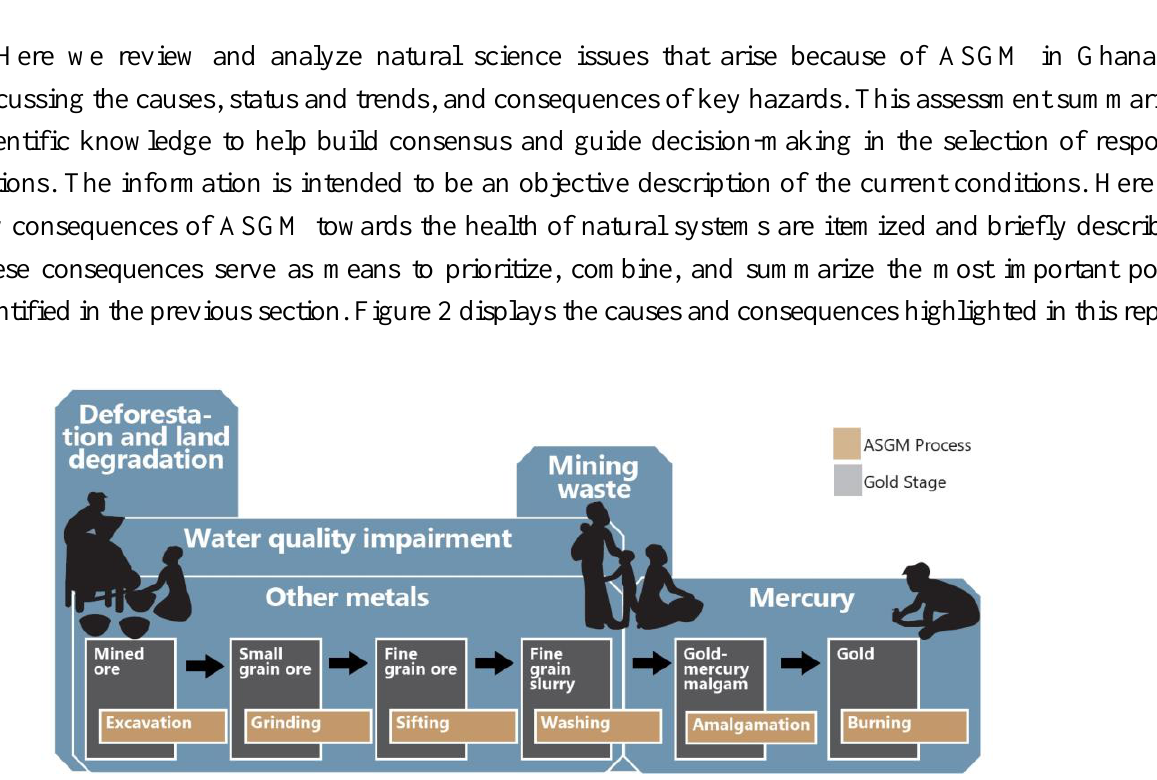
Figure 2. Key ecological hazards in the Ghanaian artisanal and small-scale gold mining (ASGM) sector. Silhouettes adapted from UNEP Mercury: Time to Act (2013)